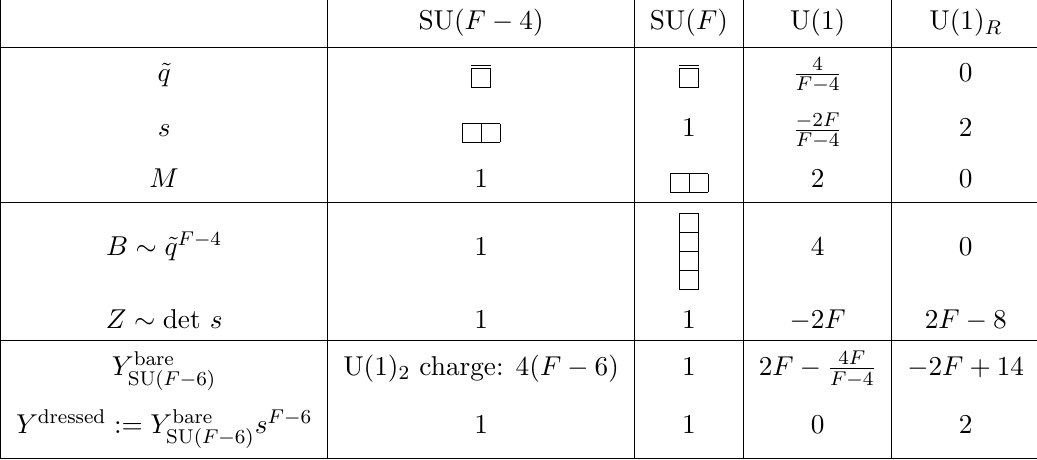
Table 3 . The SU( F (cid:0) 4) magnetic dual of table